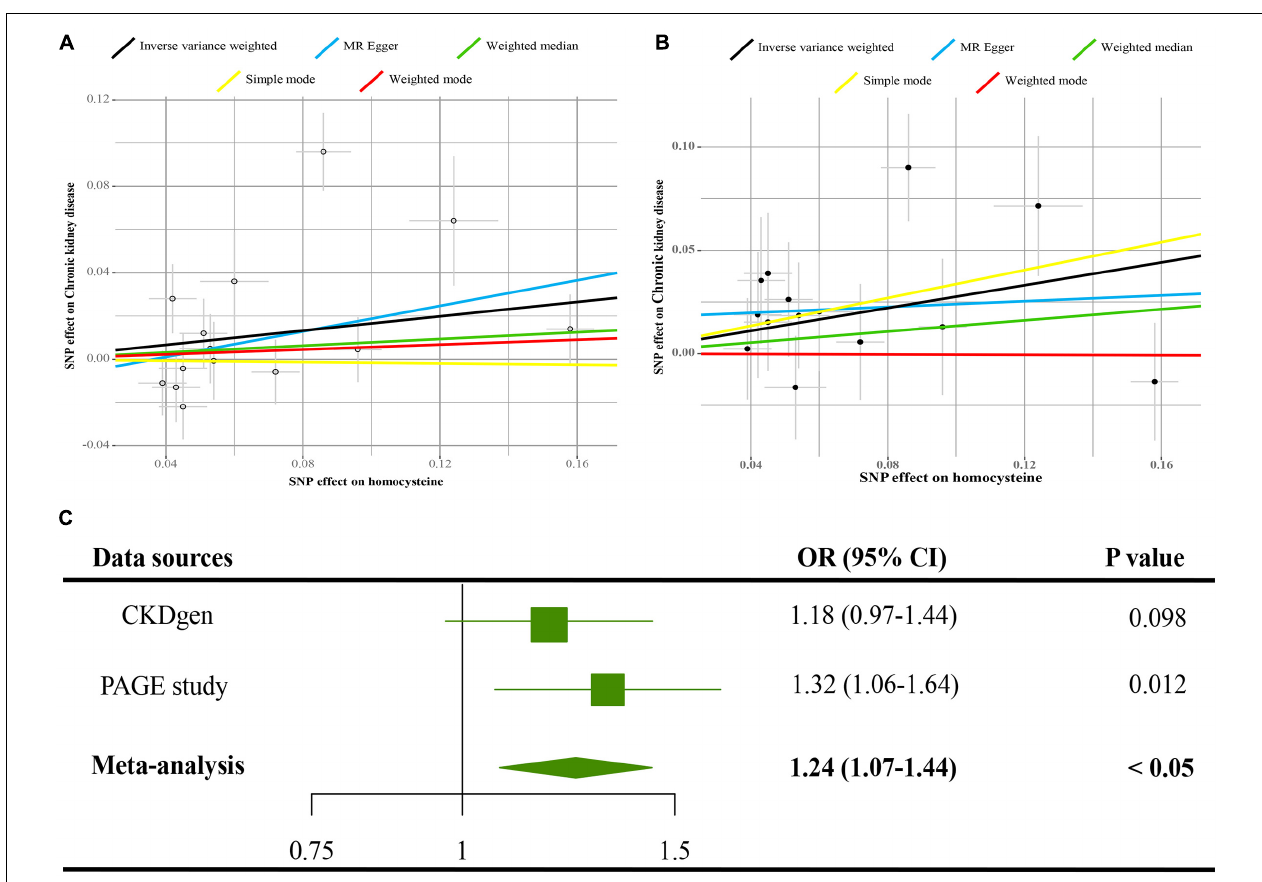
FIGURE 2 | Causal estimates of 1-SD Hcy increase on CKD. (A) Scatter plot of the effect size of each SNP on tHcy and CKD in the CKDGen project. (B) Scatter plot of the effect size of each SNP on tHcy and CKD in the Population Architecture using Genomics and Epidemiology (PAGE) project. (C) Results of the MR analyses estimating the causal association between 1-SD tHcy increase and CKD in the CKDGen and PAGE project. SD, standard deviation; Hcy, homocysteine; IVW, inverse variance weighted method; SNP, single nucleotide polymorphism; CKD, chronic kidney